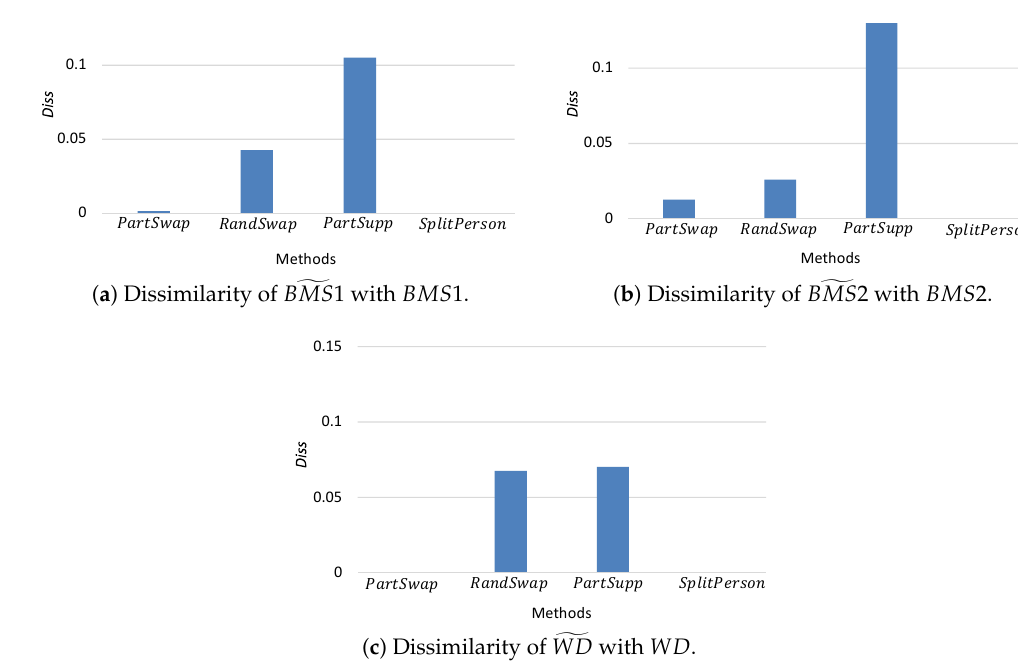
Figure 5. Diss comparison among the anonymized